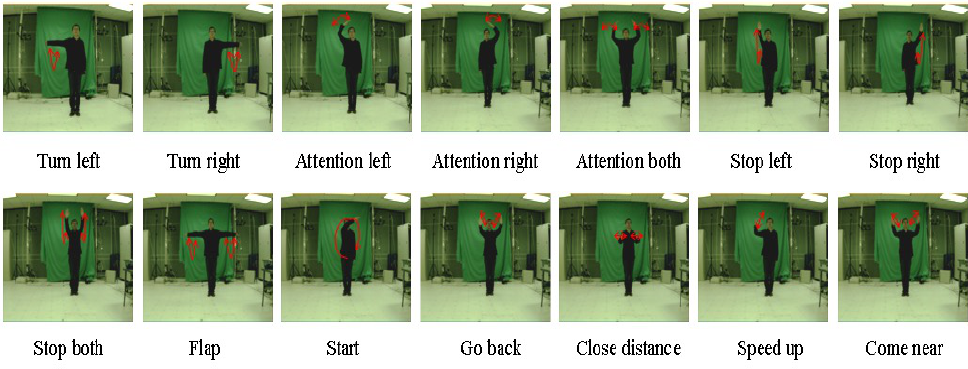
Figure 3. Sample frames of body gestures (gesture classes) from the UMD Keck body-gesture dataset.